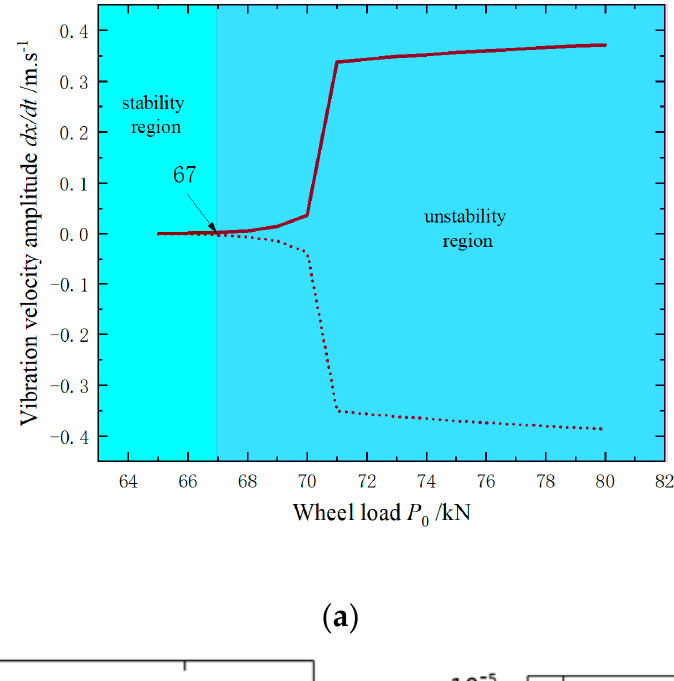
11 of 17 ( c ) Figure 6. Time domain diagram and phase diagram of wheel vibration at different speeds: ( a ) V = 36 km/h; ( b ) V = 180 km/h; and ( c ) V = 324 km/h. 4.3.2. Wheel Load The vibration characteristics of a wheel load at P 0 = 65~80 kN were investigated using β = 1.6. The bifurcation diagram in Figure 7 demonstrates this. With the increase in wheel load, the stable equilibrium point loses stability when P 0 = 67 kN, and Hopf bifurcation leads to periodic oscillation, that is, the wheel generates self-excited vibration. When P 0 < 67 kN, the time domain graph progressively converges, the phase dia- gram’s equilibrium point is the stable focus, and the wheel cannot generate self-excited vibration. As the speed increases, the time domain graphic displays the constant ampli-